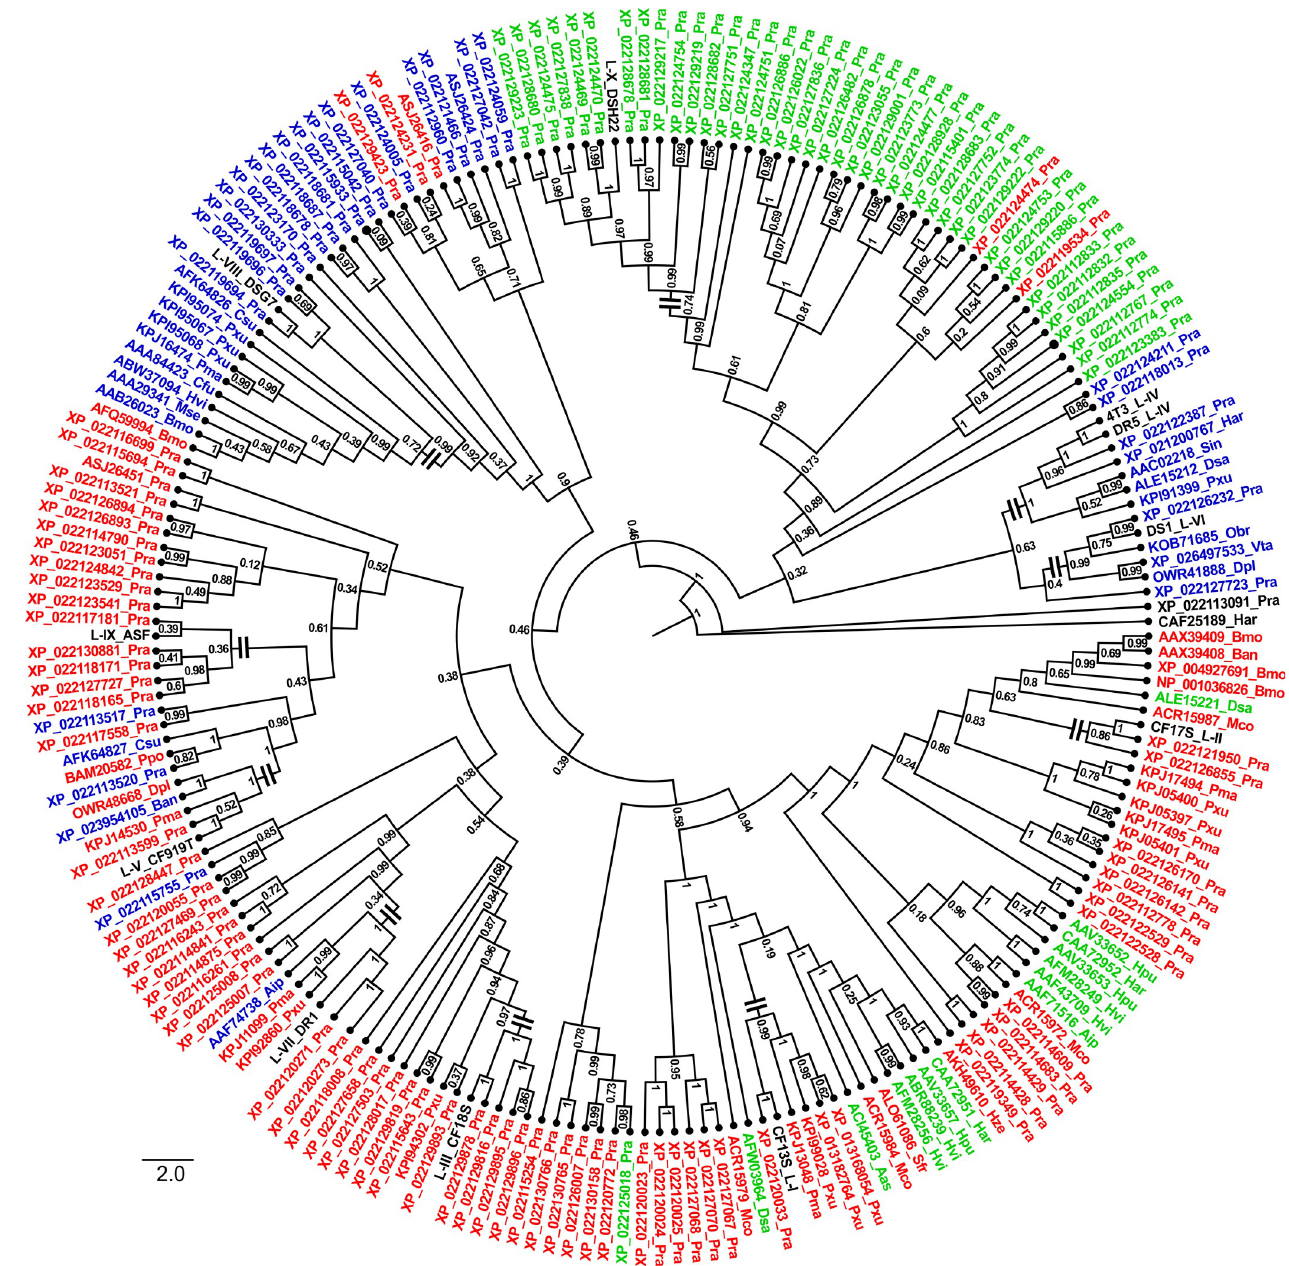
Fig 5. Sequence relatedness of serine proteases identified from P . brassicae . A Bayesian tree of serine protease sequences spanning from H 57 until S 195 (numbering after Bovine chymotrypsinogen, GenBank accession# NP_777139) identified from gut cDNAs of P . brassicae fed on CF and GN, with related homologs from P . rapae and various Lepidoptera (S1 Table). Blue markers indicate putative trypsins, green markers indicate putative chymotrypsins while red markers indicate sequences annotated as other serine proteinases. Nodes indicated by a horizontal double bar denote closely-related orthologs from various lineages of gut serine protease genes expressed in P . brassicae that show � 50% sequence similarity. The sequence of a putative carboxypeptidase from H . armigera (GenBank accession# CAF25189) was used as